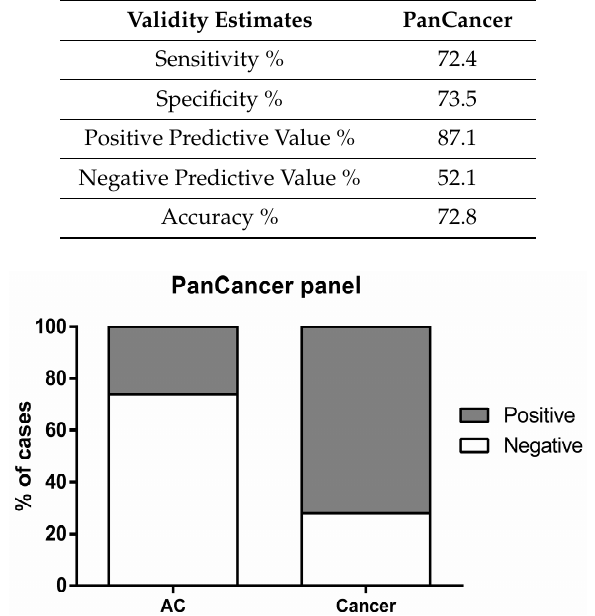
Table 2. Biomarker performance detection of “PanCancer” panel ( APC , FOXA1 and RASSF1A ) in ccfDNA.